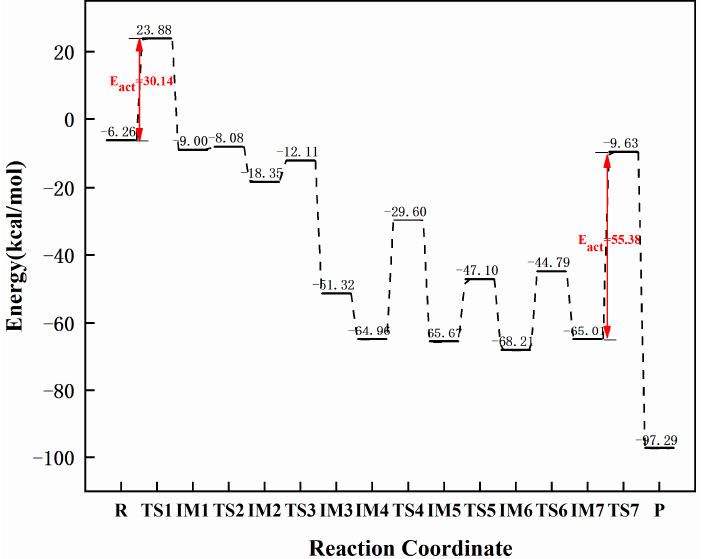
Figure 7. Optimal reaction pathway for acetylene hydrogenation catalyzed by graphene-NiN 2 (A) catalyst.